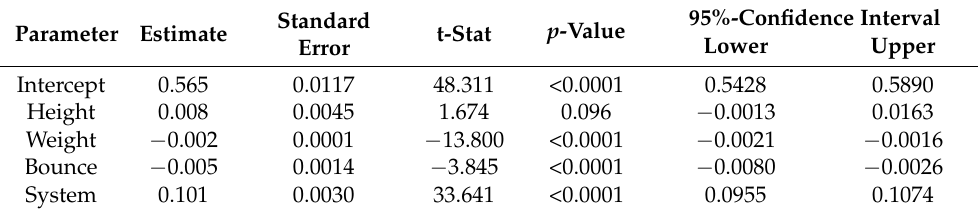
Table 5. Estimated values of the regression Model I parameters ( α = 0.05).